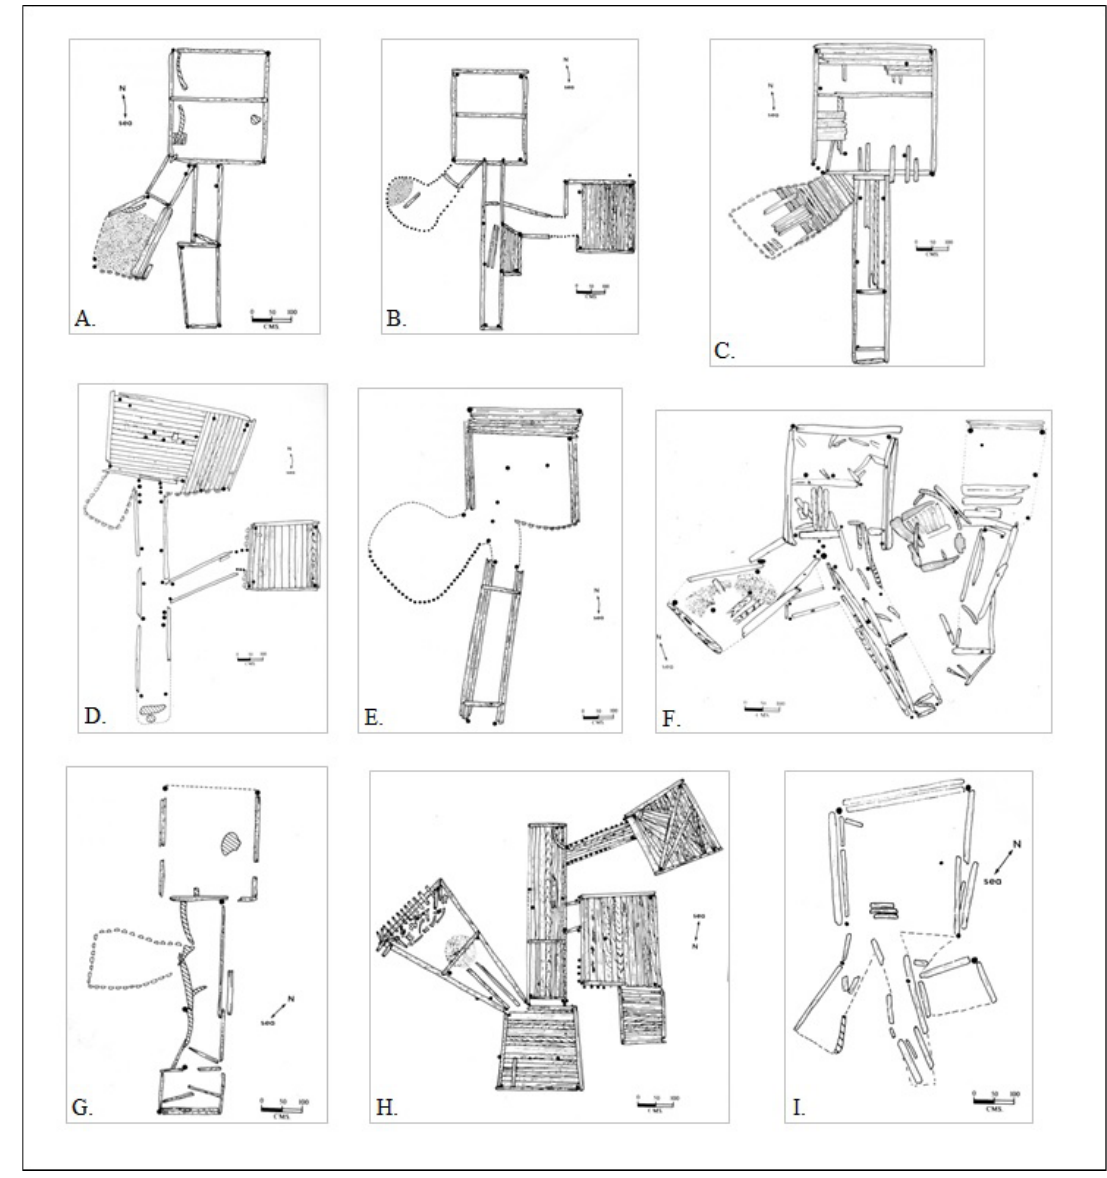
Figure 6: Cape Krusenstern early Thule houses (from Giddings and Anderson 1986: 61-79). A. House 4; B. House 5; C. House 6; D. House 7; E. House 8; F. House 25 (25a on left, 25b on right); G. House 26; H. House 27; and, I. House 29. Based on their artifact types and location, the earliest Thule houses at Cape Krusenstern are Houses